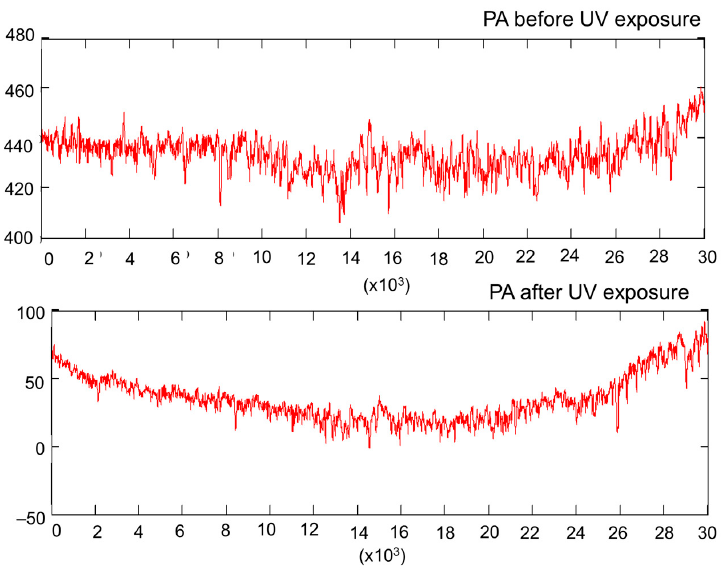
Figure 11. Measured profile of PA sycamore maple samples before and after UV treatment.